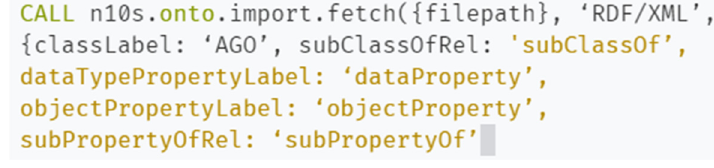
Figure 6. Main cypher query used to import the ontology.